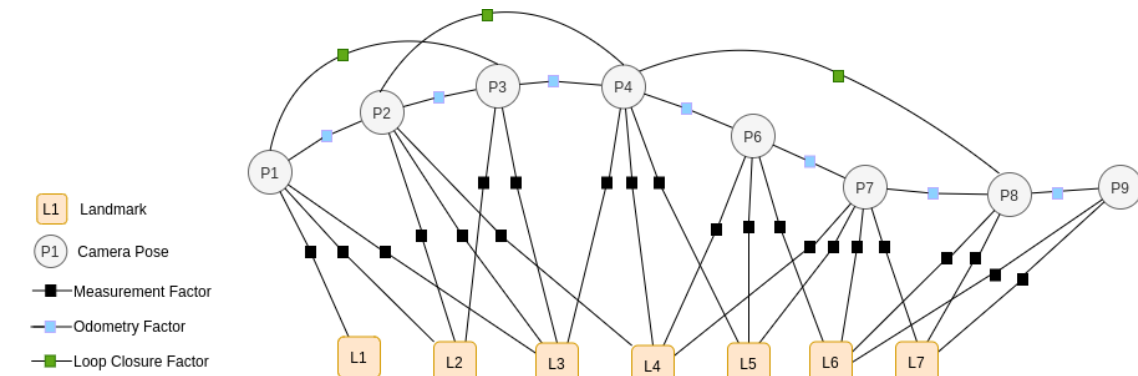
Figure 1. The factor graph is the central back-end structure for the state-of-the-art visual simultaneous localization and mapping (VSLAM) pipelines. This probabilistic graphical model stores probabilistic constraints of various kinds such as relative landmark positions and odometry measurements between camera poses. A factor graph is a bi-partite graph where the two types of nodes are variables (unknowns) and factors (constraints). Such a graphical model is used to perform maximum a posteriori inferencing to extract P ( X | Z )